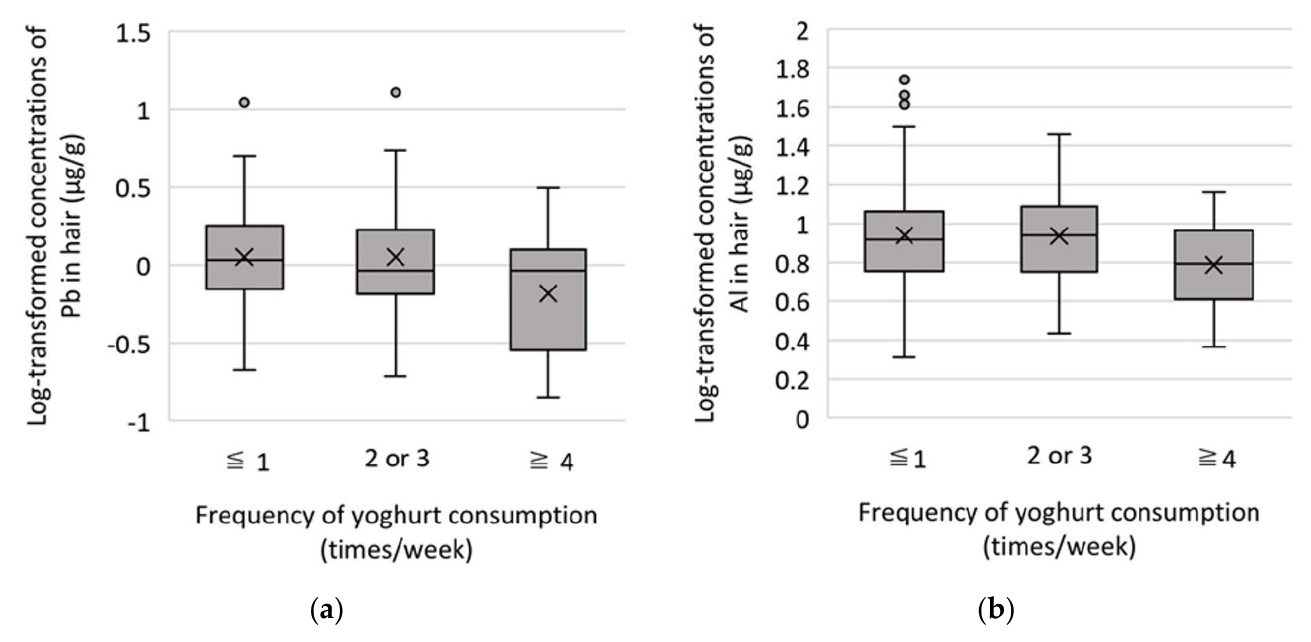
Figure 2. Boxplots showing log-transformed elements concentration of children’s hair in each frequency of yogurt consumption (times/week): ( a ) Pb; ( b ) Al. A black bar indicates the median and a black × mark the mean.